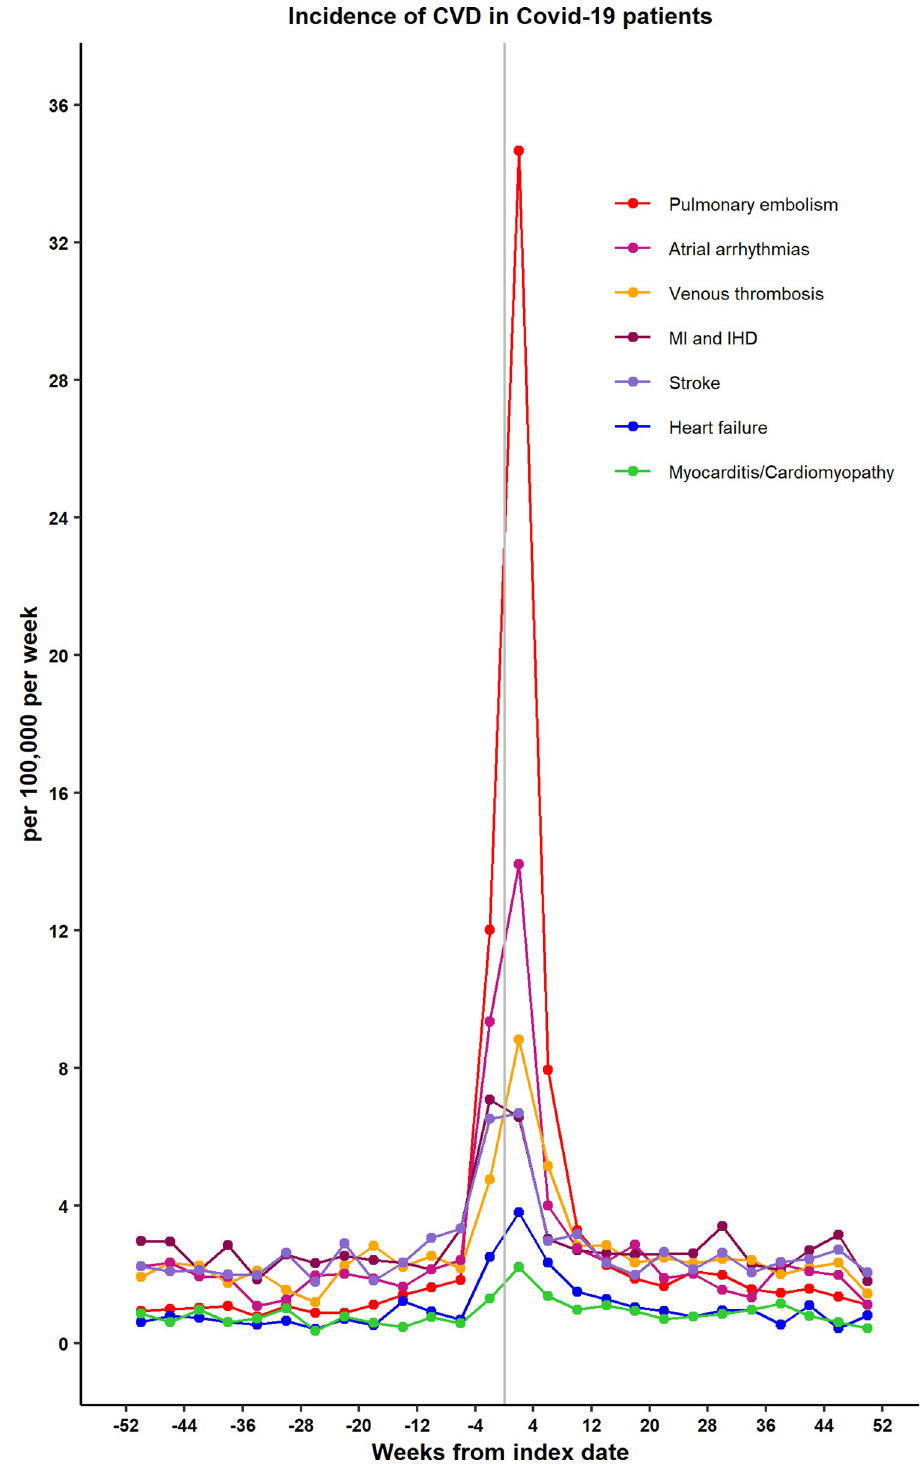
Fig 2. Incidence rates for categories of CVD (per 100,000 patient weeks) for COVID-19 patients by 4-week periods. COVID-19, Coronavirus Disease 2019; CVD, cardiovascular disease; IHD, ischaemic heart disease; MI, myocardial